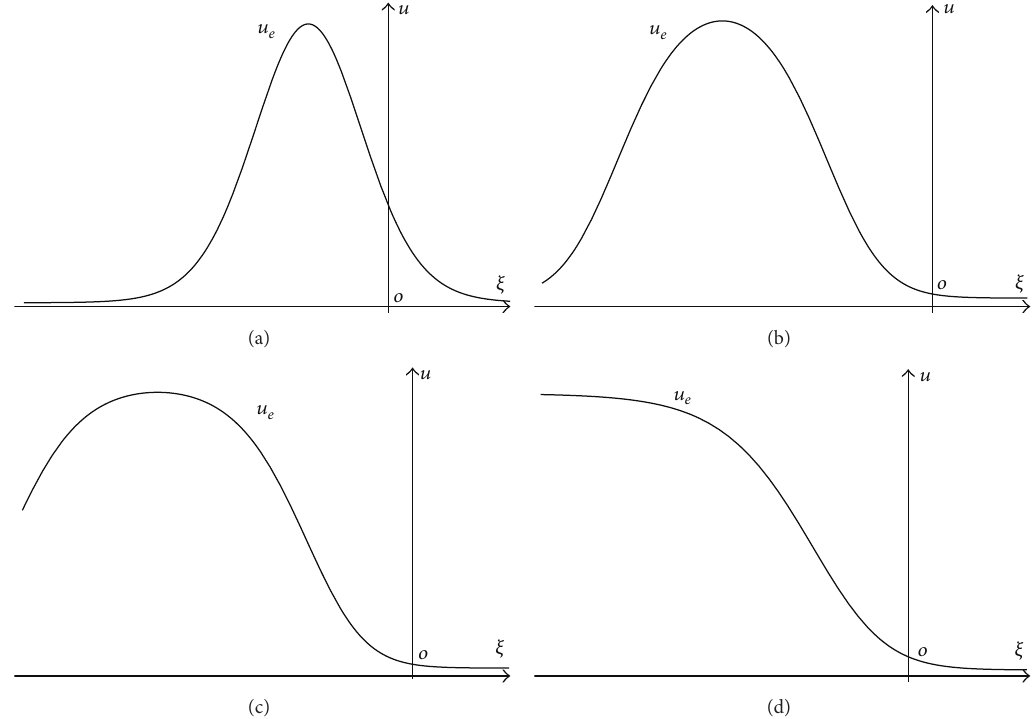
Figure 8: (The anti-kink wave is bifurcated from the bell-shape solitary wave). The varying process for the graph of 𝑢 𝑒 when 𝑐 > 0 , 𝛿 > 0 , 𝑎 > 0 , 𝜆 > 0 and 𝑏 → −16𝑎 2 /75𝑐 + 0 . Where 𝑐 = 1 , 𝛿 = 1 , 𝑎 = 1 , 𝜆 = 50 and (a) 𝑏 = −16𝑎 2 /75𝑐 + 10 −1 . (b) 𝑏 = −16𝑎 2 /75𝑐 + 10 −3 . (c) 𝑏 = −16𝑎 2 /75𝑐 + 10 −4 . (d) 𝑏 = −16𝑎 2 /75𝑐 + 10 −7